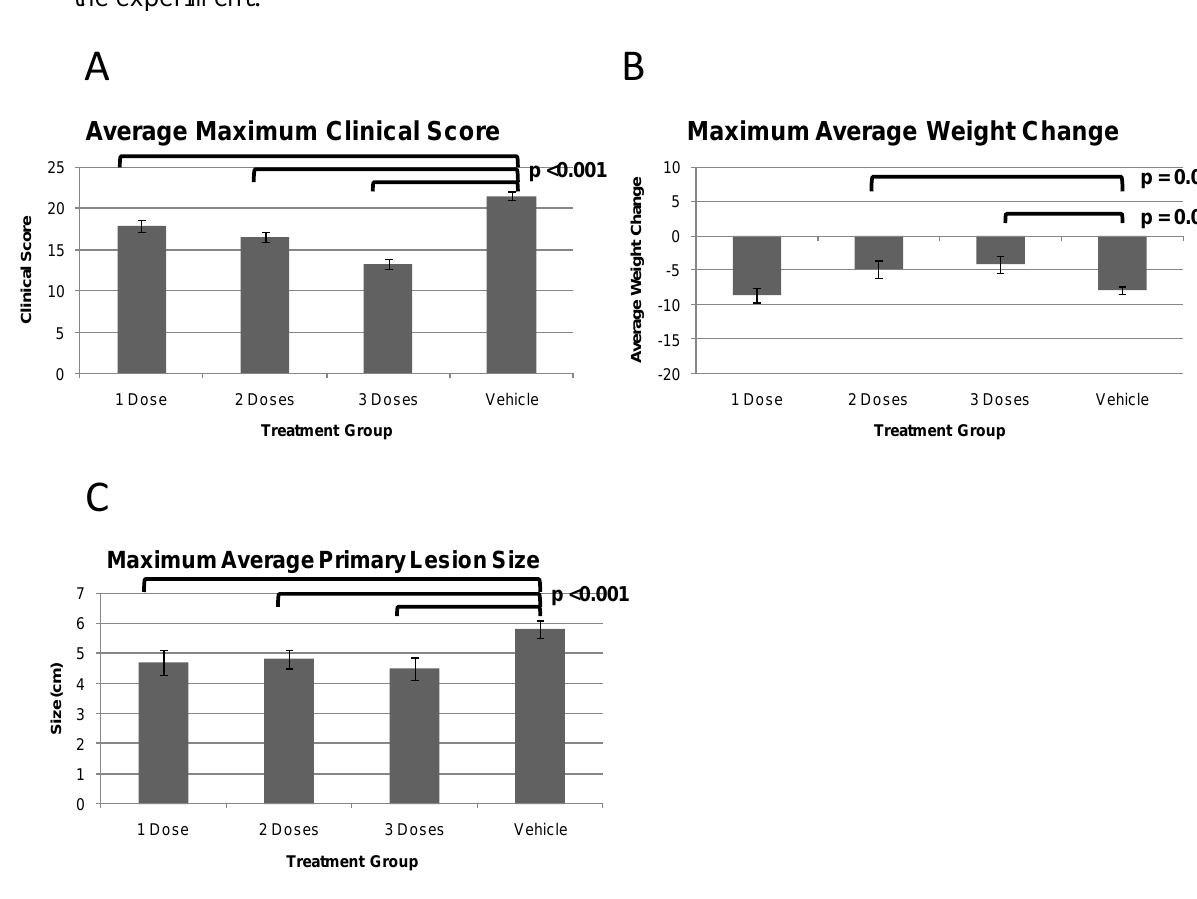
Figure 4. Disease severity measurements when CMX001 treatment began at the appearance of secondary lesions. Animals were dosed at concentrations and schedules as outlined in Table 2. (A) Average of maximum clinical scores for each animal per group over the course of the experiment. (B) Average of maximum percent weight loss from weight at day 0 for each animal per group over the course of the experiment. (C) Average of maximum diameters of primary lesions of each animal per group over the course of the